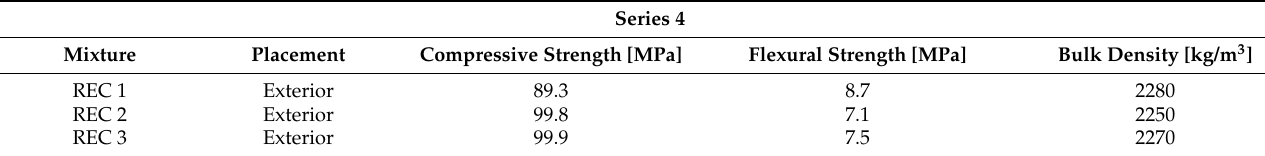
Table 8. Results of basic physical and mechanical properties for Series